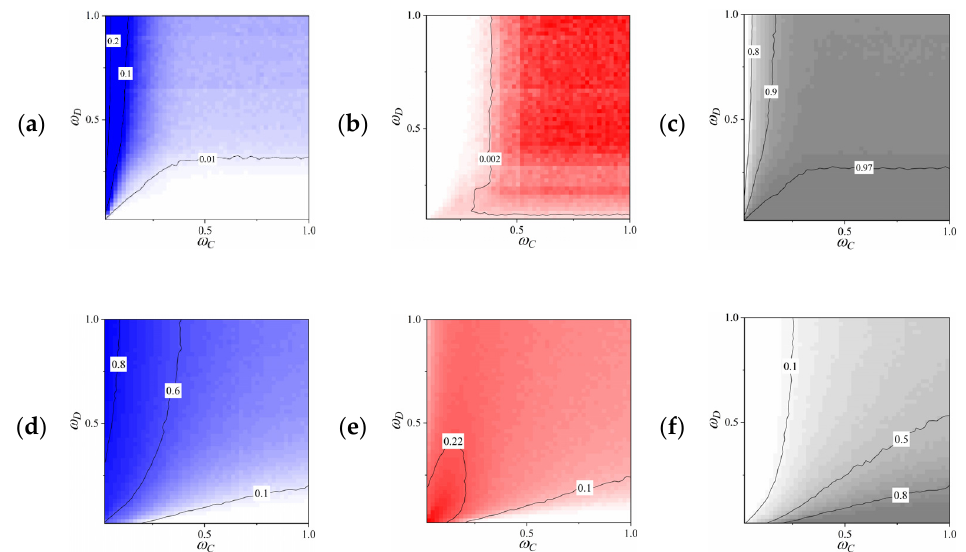
Figure A1. Fractions of cooperators (blue), defectors (red), and loners (gray) as functions of coopera- tors’ and defectors’ weights ( ω C and ω D ) in a single game for ( a – c ) r = 2.5 and ( d – f ) r = 4.5. The other parameters are the same as in Figure 4.